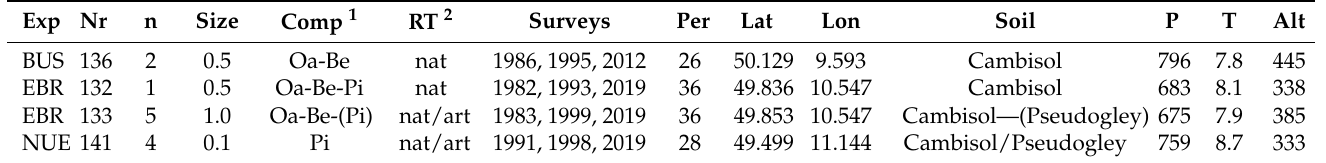
Table 1. General description of the long-term experiments; Exp—experiment (code); Nr—experiment number; n—number of plots; Size—plot sizes [ha]; Comp—species composition; RT—type of regen- eration; Surveys—measurement years; Per—regeneration period [yrs]; Lat—latitude; Lon—longitude;